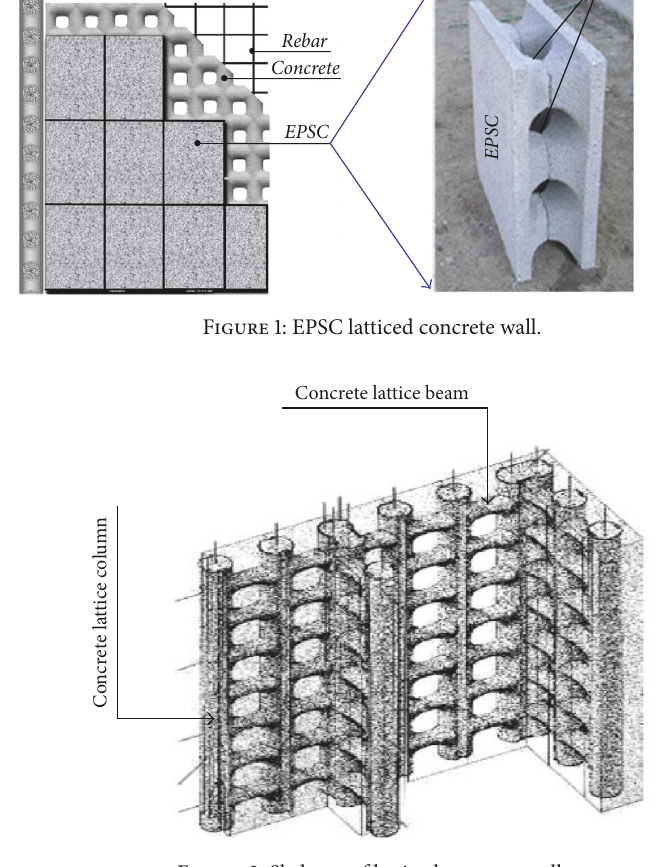
Figure 2: Skeleton of latticed concrete